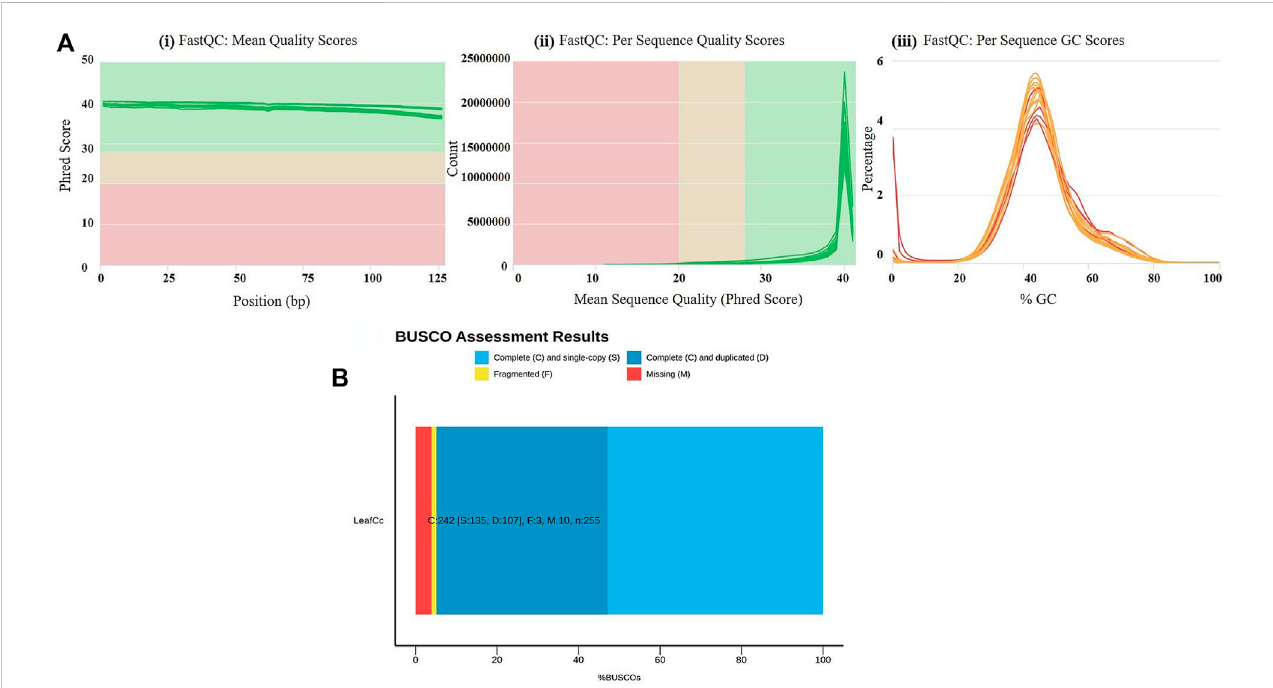
FIGURE 1 (A) Results of raw read preprocessing. (i) Mean quality scores per read. The x -axis represents the mean quality scores, and the y -axis depicts the read counts. (ii) Per sequence quality scores. The x -axis represents the position, and the y -axis depicts the Phred score. (iii) GC content of reads. The x -axis represents the GC content, and the y -axis depicts the ratio of reads. Quality assessment metrics for trimmed and fi ltered RNA-Seq data used to make the de novo transcriptome assembly. (B) % BUSCO assessment results of leaf RNAseq data in C. cajan for quality check and completeness analysis showing maximum number of unigenes categorized in complete (C), single copy (S), and duplicated (D)